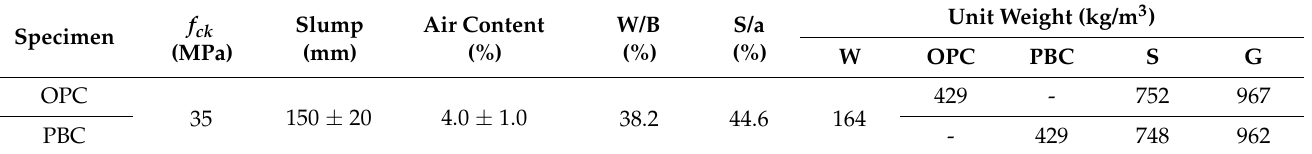
Table 5. Concrete